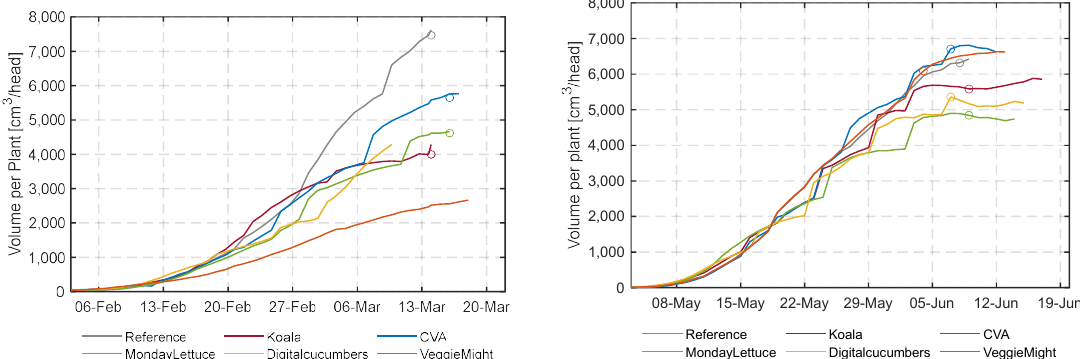
Figure 17. Daily estimated lettuce volume in all compartments during the cultivation period. Table 3. Overview of plant traits at optimal harvest date (when target weight of 250 g per lettuce head is reached). Teams are sorted from high to low volume.